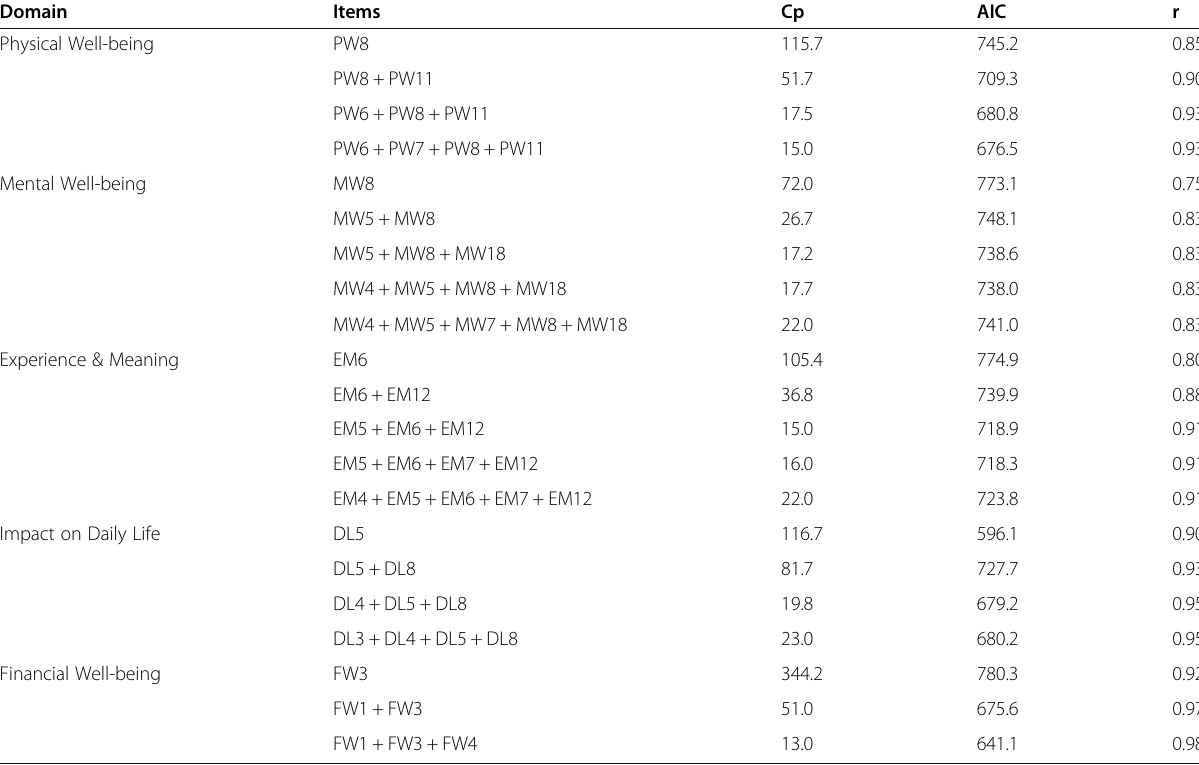
Table 2 Mallow ’ s Cp, Akaike Information Criterion (AIC) and Pearson ’ s correlation coefficient (r) with the long form domain score of the selected n -item subsets for each domain Domain